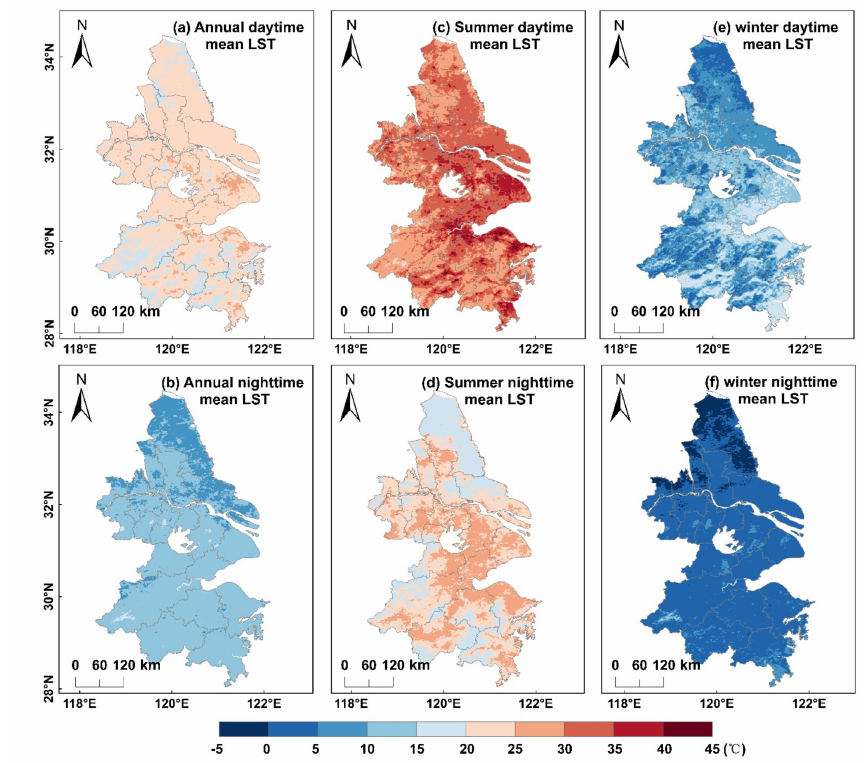
Figure 5. Spatial distribution of land surface temperature (LST) across the YRD. ( a ), ( c ) and ( e ) denote spatial distribution of annual, summer and winter daytime mean LST; ( b ), ( d ) and ( f ) denote spatial distribution of annual, summer and winter nighttime mean